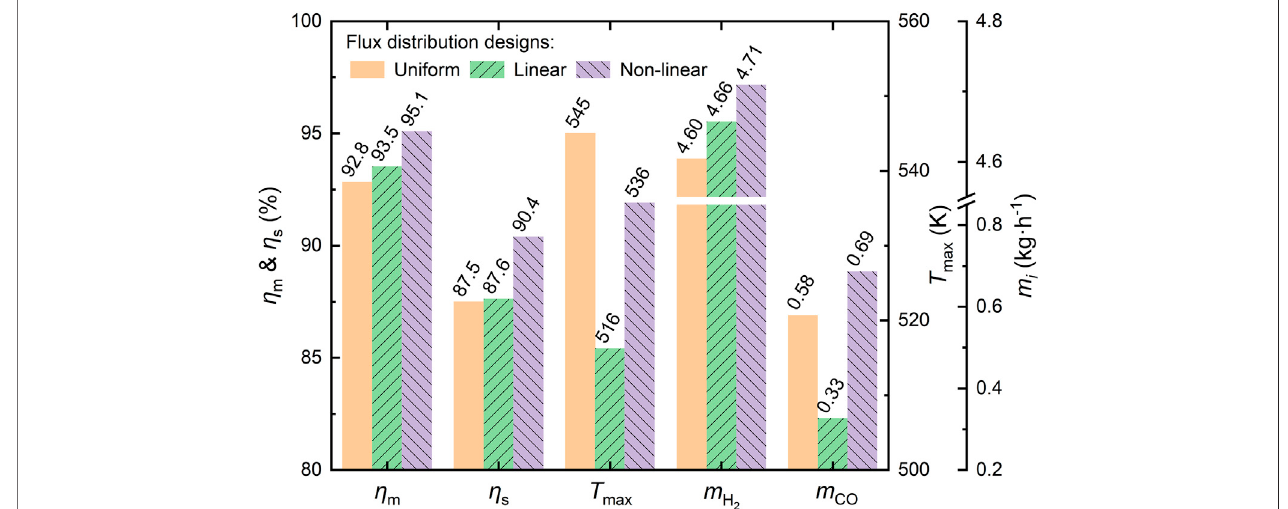
FIGURE 6 | Comparison of SPTR comprehensive performance before and after solar fl ux distribution optimization.